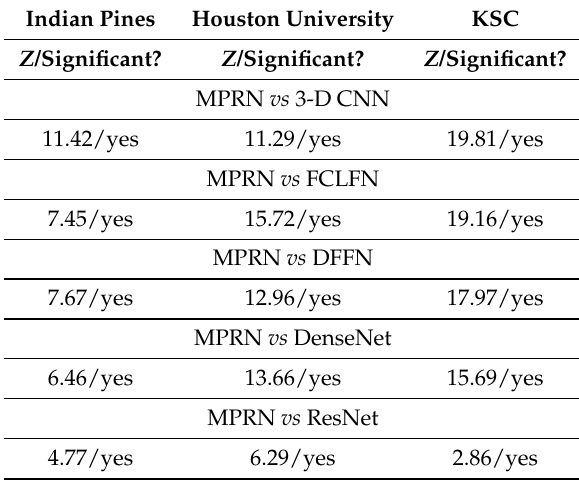
Statistical significance from the standardized McNemar’s test about the difference between